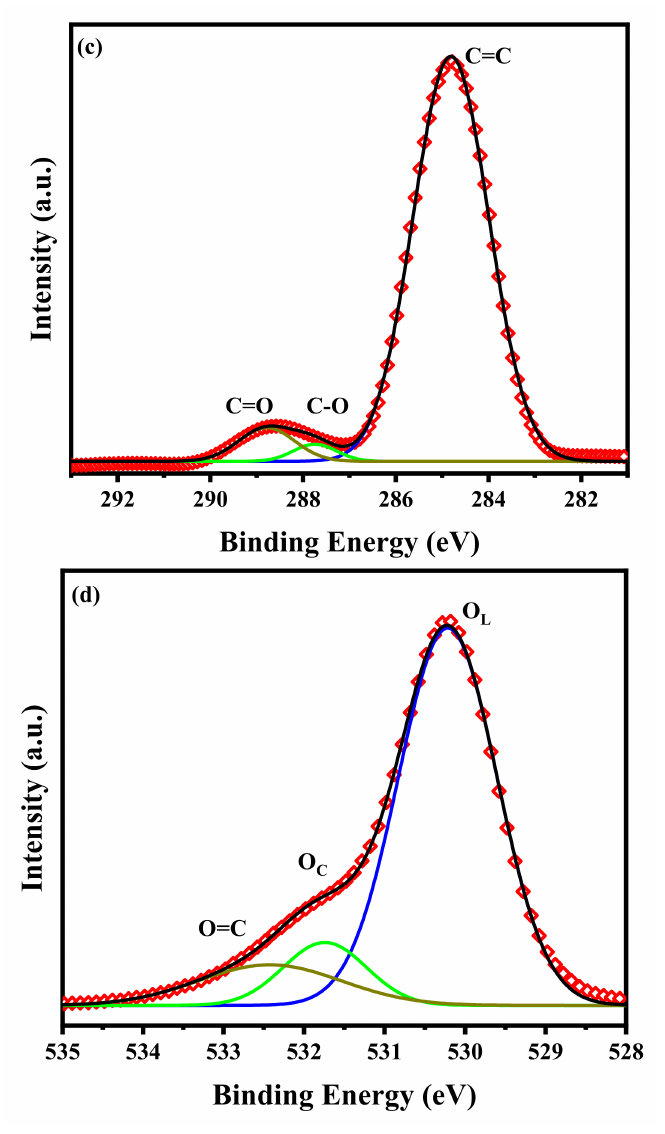
Figure 3. ( a ) Fe 2p, ( b ) Zn 2p, ( c ) C 1s, and ( d ) O 1s XPS spectra of MZG3 crystalline nanocomposites. The morphology of the elaborated nanocomposites was detected using TEM as pre- sented in Figure 4. It was found that the distribution of Fe 3 O 4 /ZnO (MZ) nanocomposites on the sheets of reduced graphene oxide depends on the ratio between rGO and MZ. The TEM images of the MZGx nanocomposites indicated the presence of a two-dimensional structure of rGO with nanoparticles of Fe 3 O 4 /ZnO, which were well dispersed on the graphene sheet [48,49]. Moreover, we can see that MZG3 (Figure 4f) presented a homoge- neous distribution. By contrast, MZG4 (Figure 4g) had more aggregation of rGO. All of this information is consistent with the XRD and Raman sections. Moreover, the MZG3 nanocom- posite was detected using high-resolution transmission electron microscopy (HRTEM) as presented in Figure 4h. The d-lattice spacing was detected as 0.265 ± 0.05 nm and 0.301 ± 0.04 nm for (100) ZnO and (220) Fe 3 O 4 , respectively [50,51]. Consequently, the HRTEM result shows that the ZnO and Fe 3 O 4 were tightly connected to each